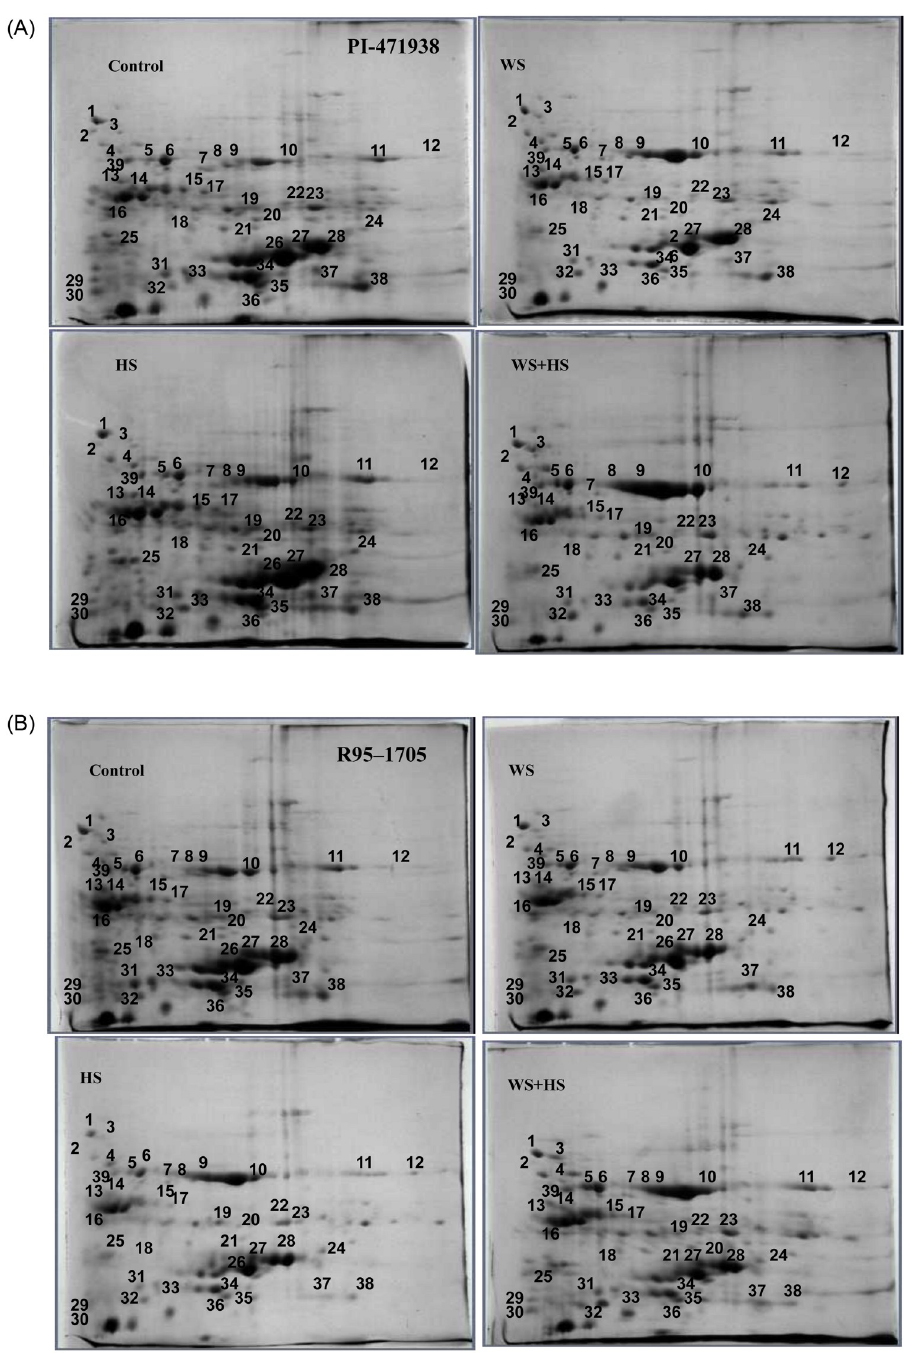
Fig 2. Changes in leaf protein abundance (protein spots with numbers) to water (WS), heat (HS) and combined water and heat stress (WS+HS) in soybean cultivars PI-471938 and R95-1705.